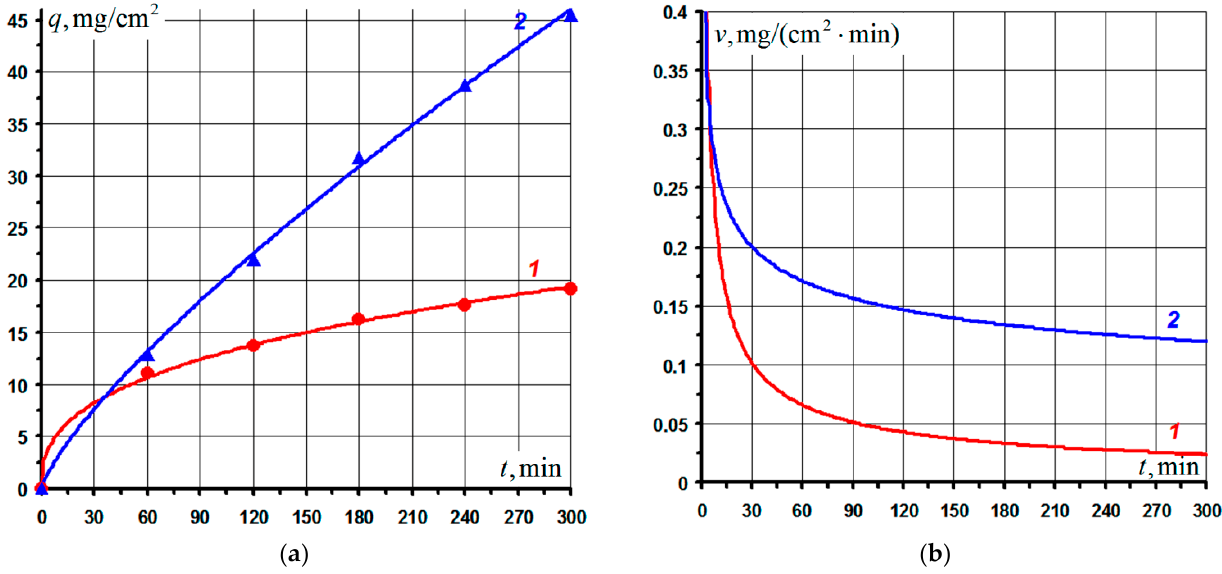
Figure 2. Kinetic curves of the oxidation of compacts from powders of experimental composition in the Si–TiSi2–MoSi2–TiB2–CaSi2 system (1) and basic composition in the Si–TiSi2–MoSi2–TiB2 system (2) at 1650 °C in air ( a ) and their corresponding oxidation rates ( b ).